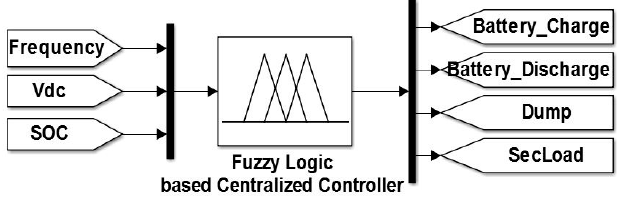
Figure 8 . Fuzzy logic-based frequency and voltage control system. Figure 8. Fuzzy logic-based frequency and voltage control